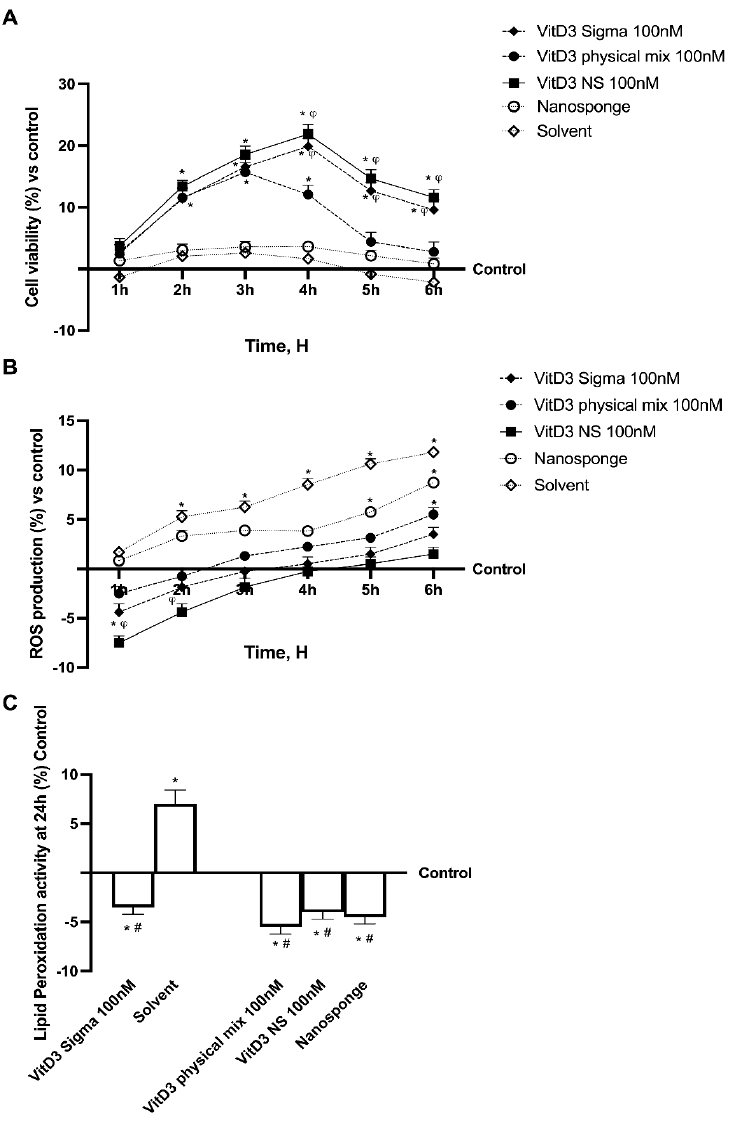
Figure 2. Analysis of different forms of VitD3 in time-dependent study. ( A ) Mitochondrial Metabolism, ( B ) ROS production and ( C ) Lipid Peroxidation analysis. Data are expressed as mean ± SD (%) of 5 independent experiments normalized to control. ( A , B ) * p < 0.05 vs. con- trol; ϕ p < 0.05 vs. VitD3 physical mix 100 nM ( C ) * p < 0.05 vs. control (untreated cells); # p < 0.05 vs. Solvent